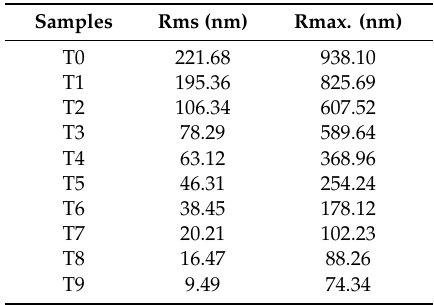
Figure 4. Atomic force microscopy (AFM) surface of SEBS: ( a ) without exposure (T0), ( b ) UV exposure T2, ( c ) UV exposure T7 and ( d ) UV exposure T9. Table 3. Roughness of UV exposure times of samples of SEBS.